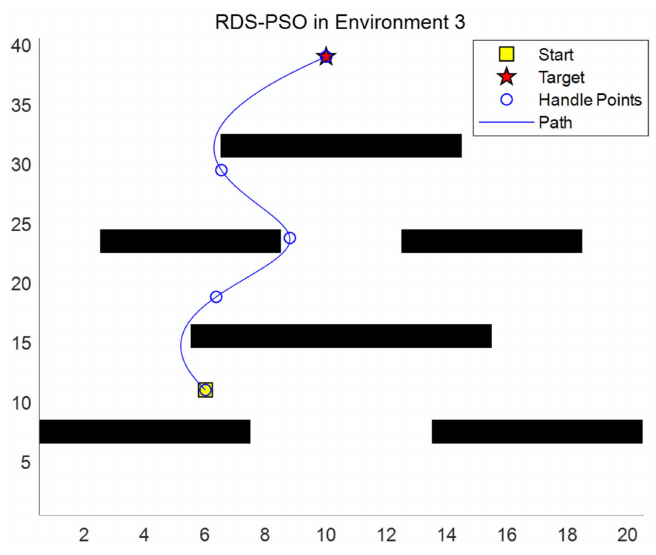
Figure 10. Path planning of RDS-PSO in map